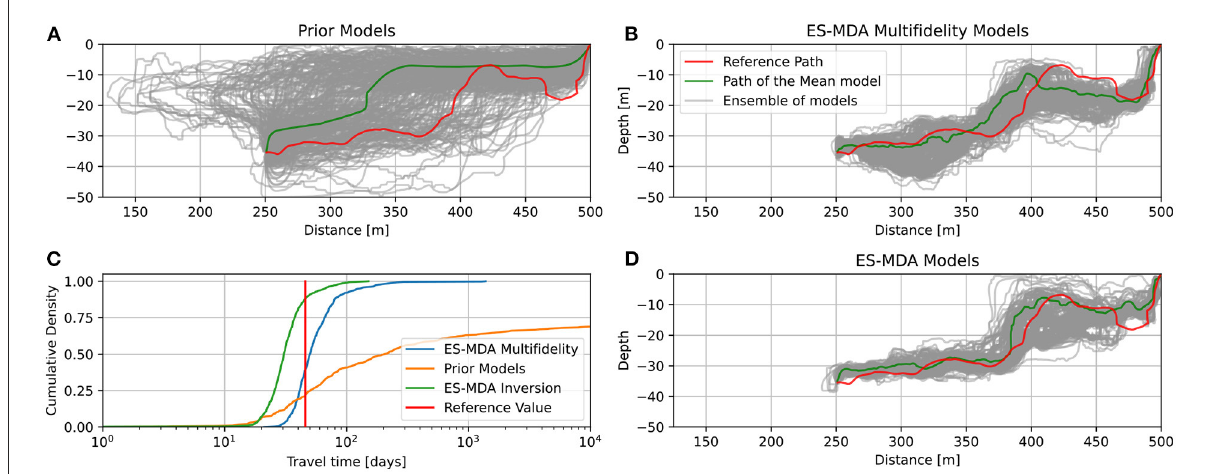
FIGURE10 (A,B) Flow lines for the prior and posterior multifidelity ensemble of model C2. (C,D) Distribution of the travel time from the river to the well and Flow lines for the posterior monofidelity ensemble of model